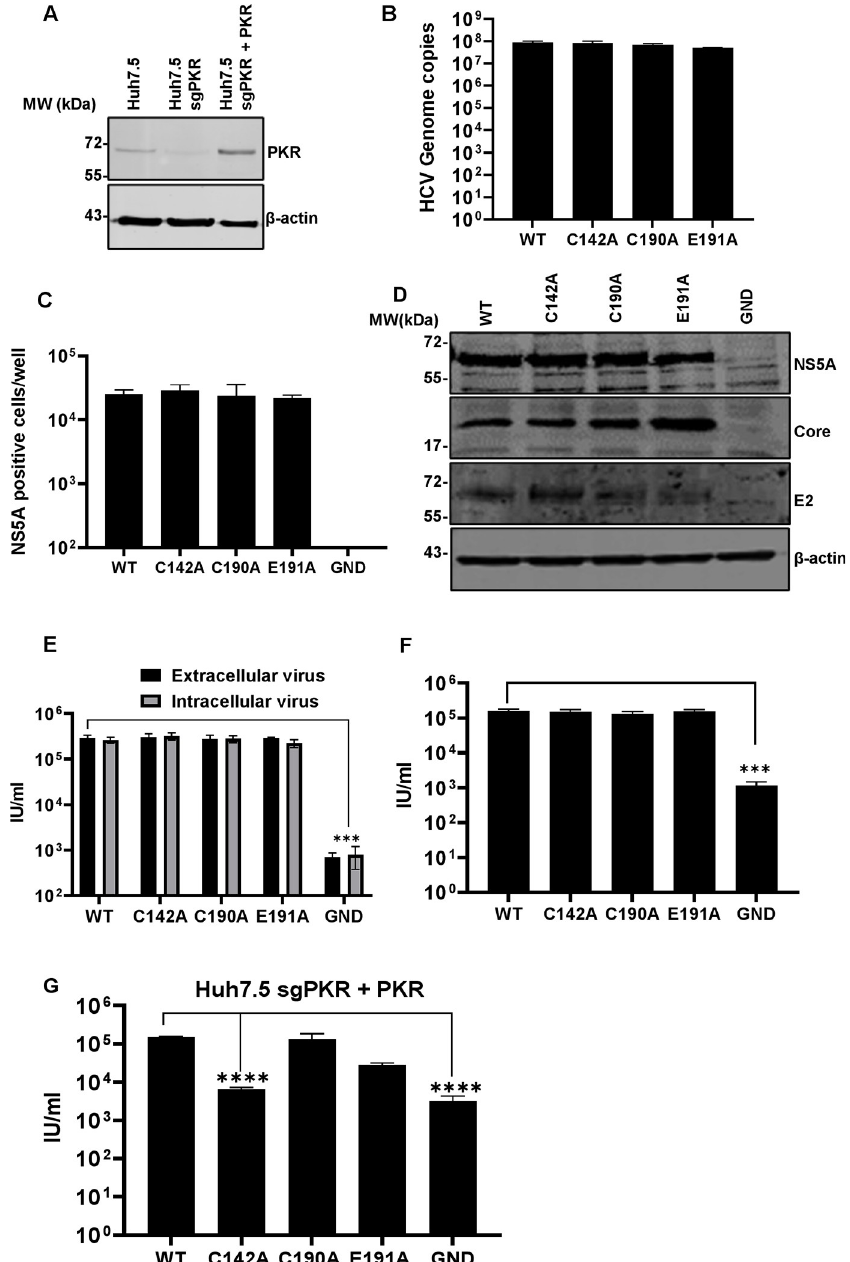
Fig 6. Virus assembly in PKR-silenced Huh7.5 cells. (A) PKR expression was detected in control Huh7.5 cells, silenced (Huh7.5 sgPKR), and cells subsequently transfected with pcDNA3.1-PKR by western blot (Huh7.5 sgPKR + PKR). ( B-F ) Huh7.5 cells were electroporated with mJFH-1 WT and DI mutant C142A, C190A and E191A RNAs, together with an NS5B GND mutant as negative control. Virus genome replication was analysed directly by quantification of genome copies in cell lysates using qRT-PCR, data shown have the GND values subtracted ( B ), and indirectly by enumerating NS5A positive cells at 72 hpe using the IncuCyte S3 ( C ). (D) Cell lysates were collected at 72 hpe and analysed by western blotting with the indicated antibodies. (E) Extra- and intracellular virus harvested at 72 hpe were titrated in Huh7.5 cells and quantified using the IncuCyte S3. ( F) Electroporated cells were treated with the PKR inhibitor C16 (1 μ M) from 24 hpe, extracellular virus was harvested at 72 hpe, titrated in Huh7.5 cells and quantified using the IncuCyte S3. (G) Extracellular virus harvested at 72 hpe was titrated in Huh7.5 cells and quantified using the IncuCyte S3. N = 3, significant differences from WT denoted by ��� (P < 0.001) and ���� (P < 0.0001).